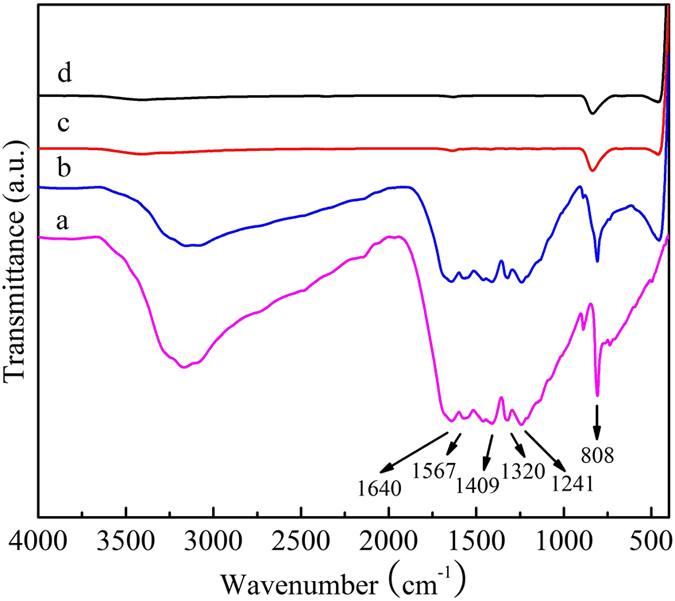
FT-IR spectra of g-C3N4 (a), b-TiO2/g-C3N4 (b), TiO2 (c) and b-TiO2 (d), respectively.